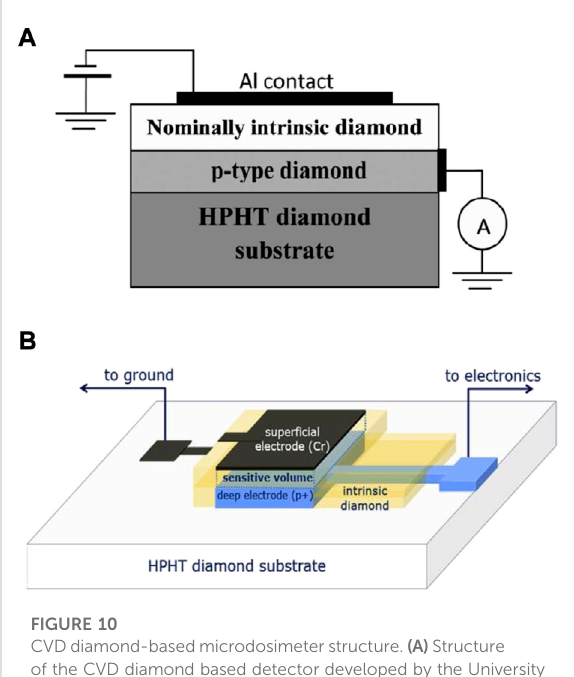
FIGURE 10 CVDdiamond-basedmicrodosimeterstructure. (A) Structure of the CVD diamond based detector developed by the University ofRomaTorVergata.Source:[98]. (B) Schematicrepresentationof the diamond-based microdosimeter introduced by Verona et al.